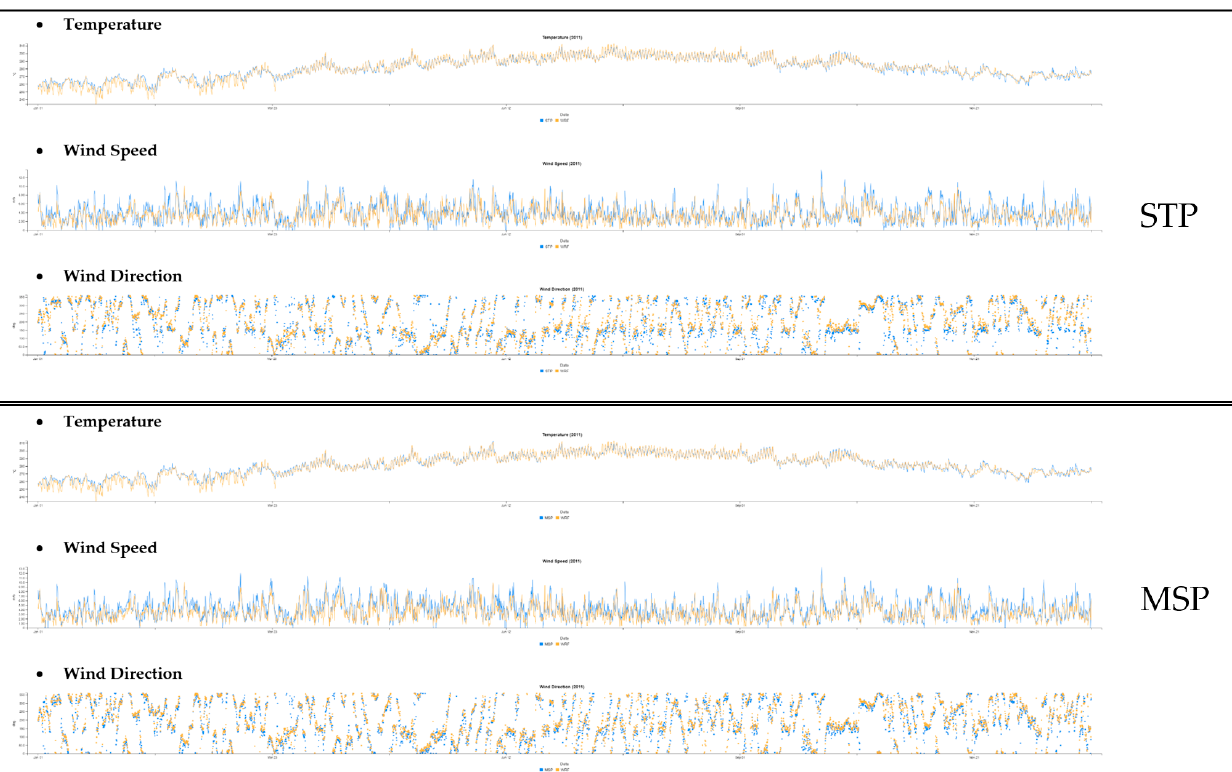
Figure A3. Hourly Time Series Data for Temperature, Wind Speed, and Wind Direction in 2011 at Saint Paul Downtown Airport (STP) ( Top ) and Minneapolis–Saint Paul International Airport (MSP) ( Bottom ). The data is compared between the WRF model (represented in orange) and surface weather observation stations (represented in blue).